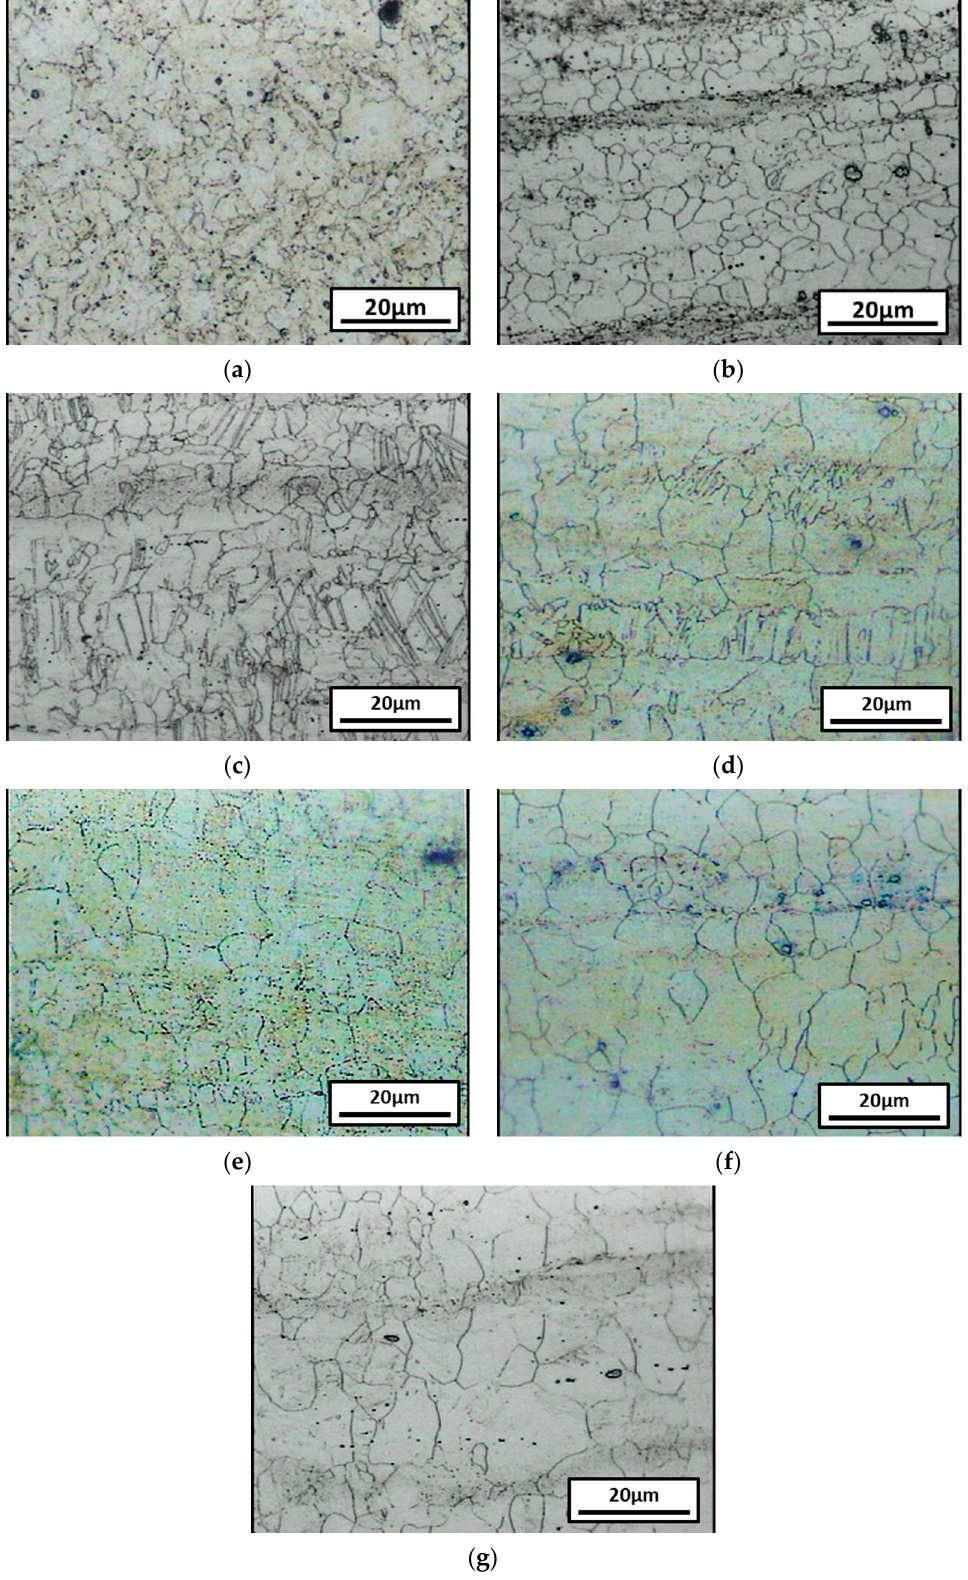
Figure 4. Microstructure of ZKX500 Mg alloy: ( a ) F, ( b ) FH, ( c ) FR, ( d ) FRH05, ( e ) FRH10, ( f ) FRH30, and ( g ) FRH60.